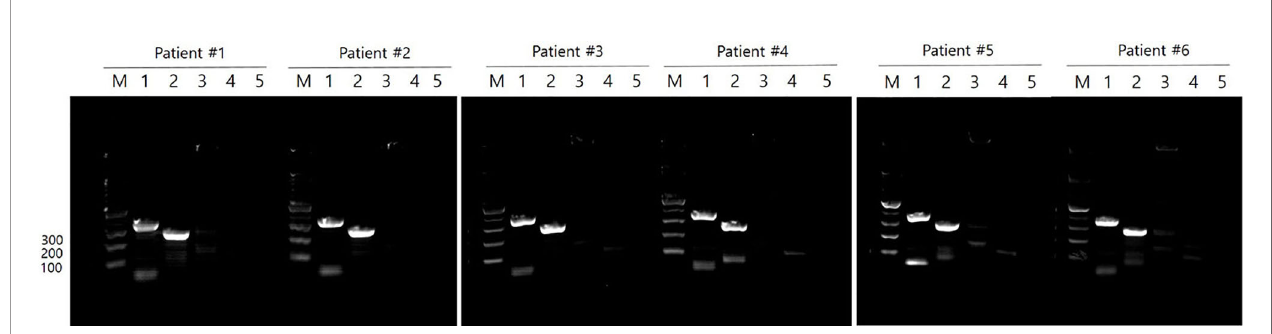
FIGURE 2 | M. tb genotypes in clinical isolates. M. tb genotypes were con fi rmed by PCR in 6 of 10 patients who showed M. tb growth in culture. All clinical isolates were Beijing/K strains of M. tb . M: 100 bp DNA ladder, Lane 1: Beijing strain (~ 350 bp), Lane 2: K strain (~ 250 bp), Lane 3: M strain (~ 150 bp), Lane 4: Non- Beijing strain (~ 500 bp), Lane 5: